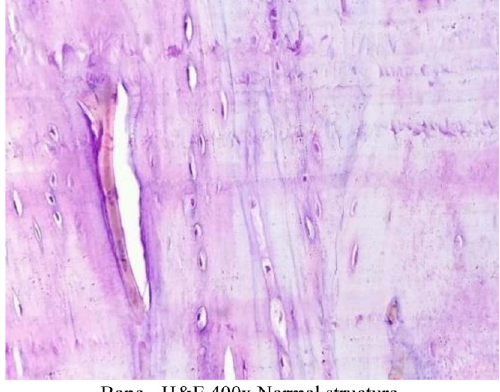
Fig. 6 . Histopathology of decalcified bone of group 6 (Diabetic control)